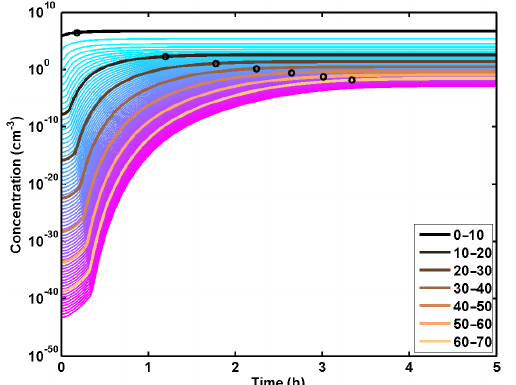
Figure A2. The time evolution of the cluster distribution during the first 5h of one of the simulations, where the steady-state monomer concentration was set to 5 × 10 6 cm − 3 , the loss coefficient to 10 − 3 s − 1 , and the saturation vapor pressure to 2 × 10 − 10 Pa. The concentrations of the vapor monomer and the individual clusters are shown as the lines with colors from light blue to pink. The different size bins, for which the growth rates were determined, are shown as the thick lines with colors from black to light brown. The black circles mark the appearance times of each size